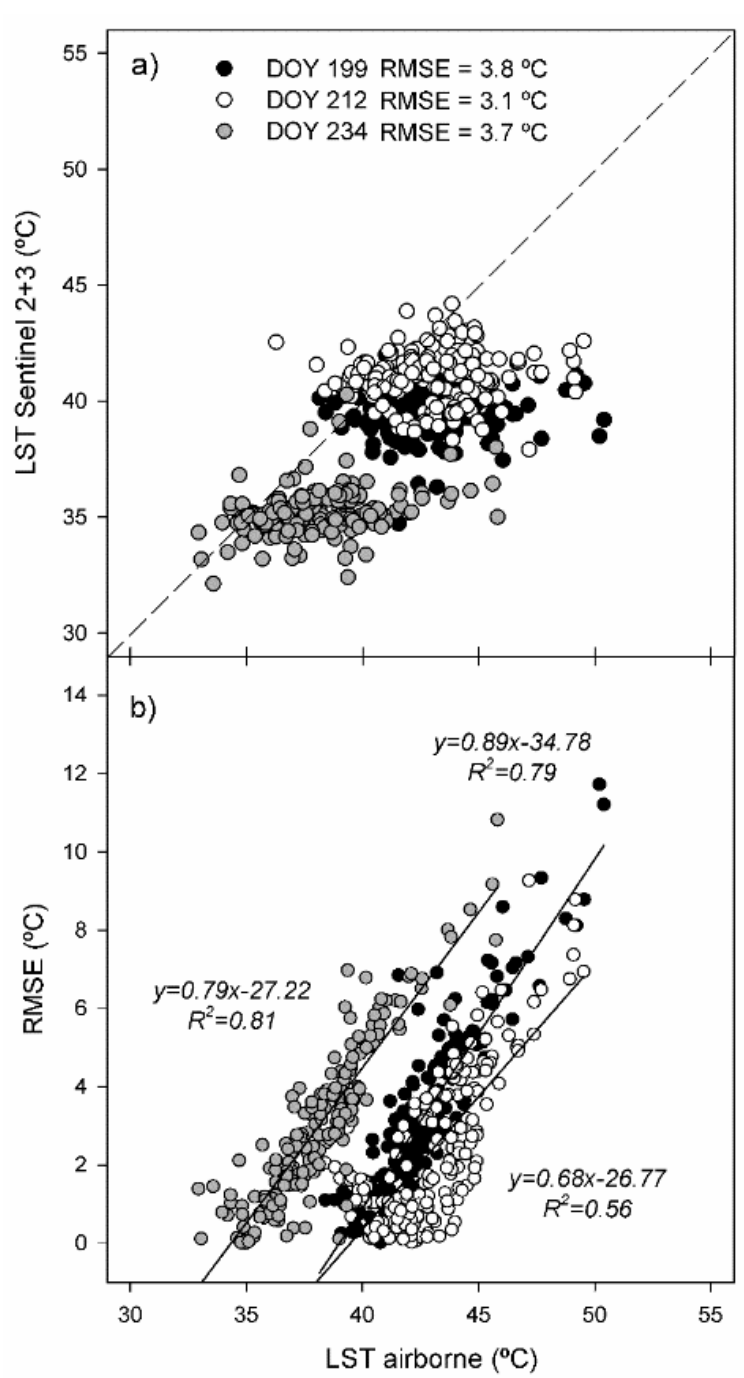
Figure 2. Scatterplots comparing the land surface temperature (LST) of the vineyard obtained with ( a ) the data mining sharpening (DMS) approach using Sentinel-2 and Sentinel-3 images and very high-resolution airborne imagery, and ( b ) the root mean square error (RMSE) of sharpened and airborne LST against airborne LST.